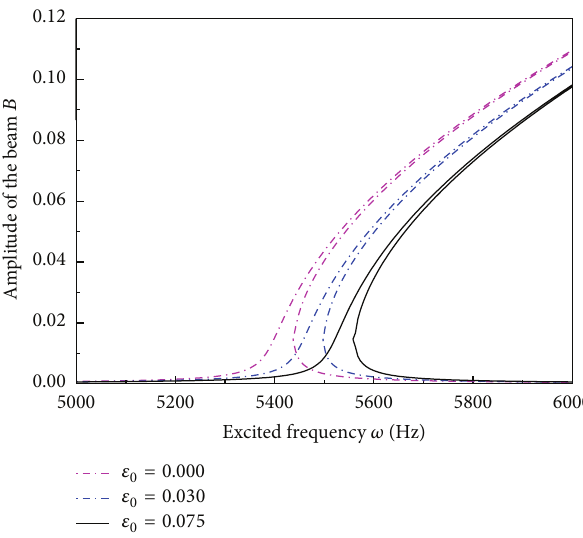
Figure 15: Amplitude 𝐵 versus frequency responses of the com- posite beams in the phase transformation state from martensite to austenite under the excitations for different 𝑉 𝑠 ( T = 60 ∘ C, 𝜀 0 = 0.008 , = 10 N, and 𝐿/ℎ = 10 ). 𝑞 0